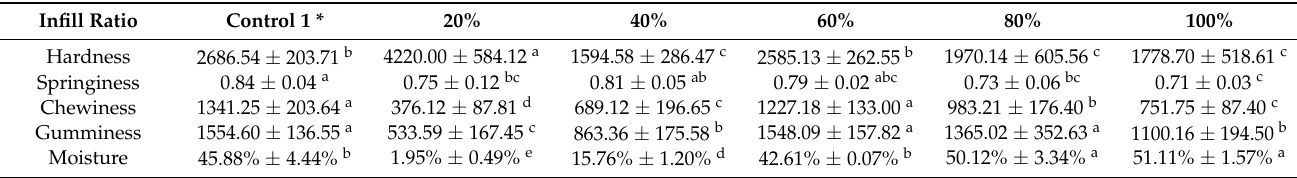
Table 6. Texture and moisture results of samples with different infill ratios after frying.